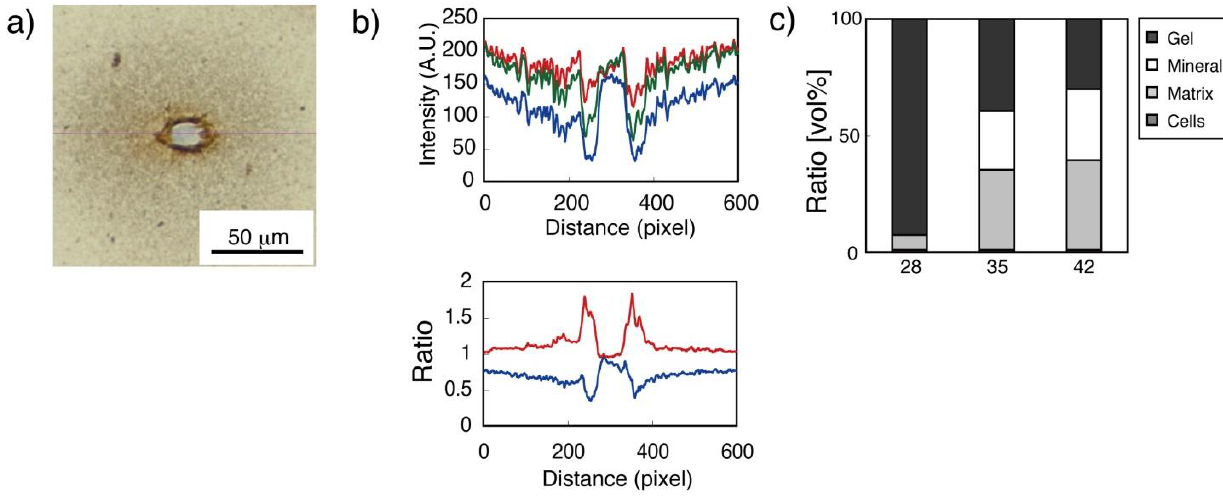
Figure 8. ( a ) Representative von Kossa-stained image of a single bone marrow derived mesenchymal stem cell (BMSC) in fibrin gel. Unstained cell nuclear, dark stained cell plasma, and distributed mineral deposition around the cell are observed. Horizontal line crossing center of cell nuclear used to obtain RGB color information; ( b ) Line profile of color intensity in each RGB color obtained from line shown in (a) (upper). Red line obtained by R/G from RGB color intensity indicates mineral deposition; blue line obtained by B/G from RGB color intensity indicates cell nuclear (lower); ( c ) Estimated volume ratio of components in 3D gel construct with different culture